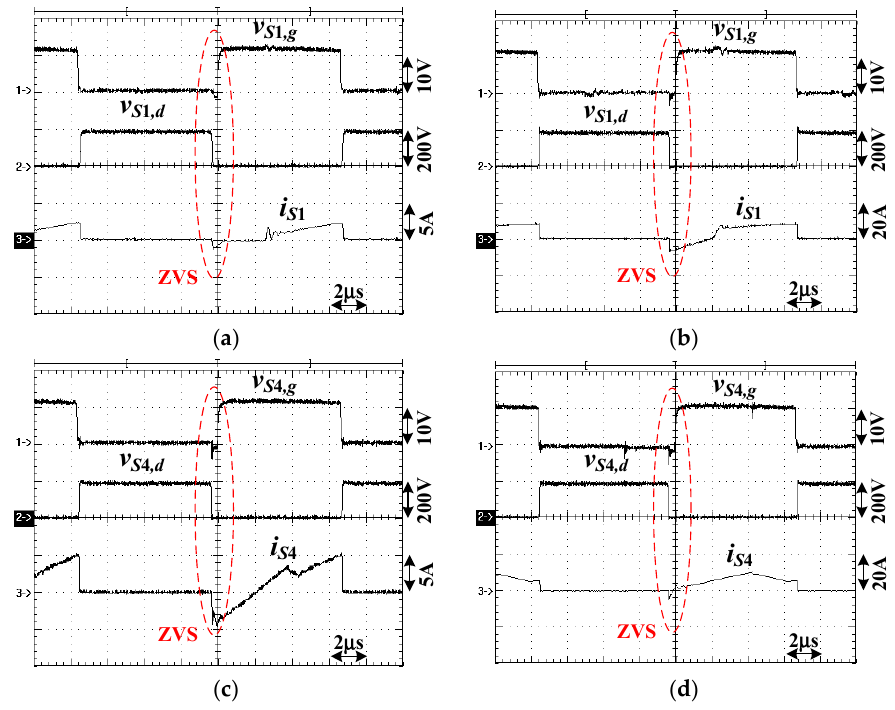
Figure 11. Measured results of S 1 and S 4 at V in = 190 V input ( a ) S 1 waveforms at 160 W (20% load) ( b ) Scheme 1 . waveforms at 800 W (full load) ( c ) S 4 waveforms at 160 W (20% load) ( d ) S 4 waveforms at 800 W (full load).